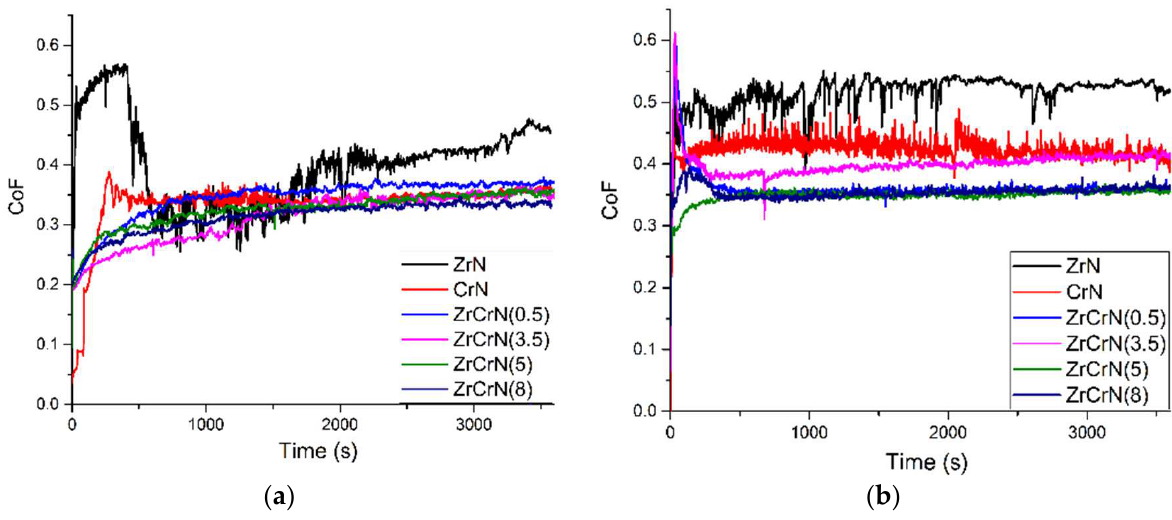
Figure 2. CoFs vs. time dependencies for sliding at 1N ( a ) and 6N ( b ) normal load.